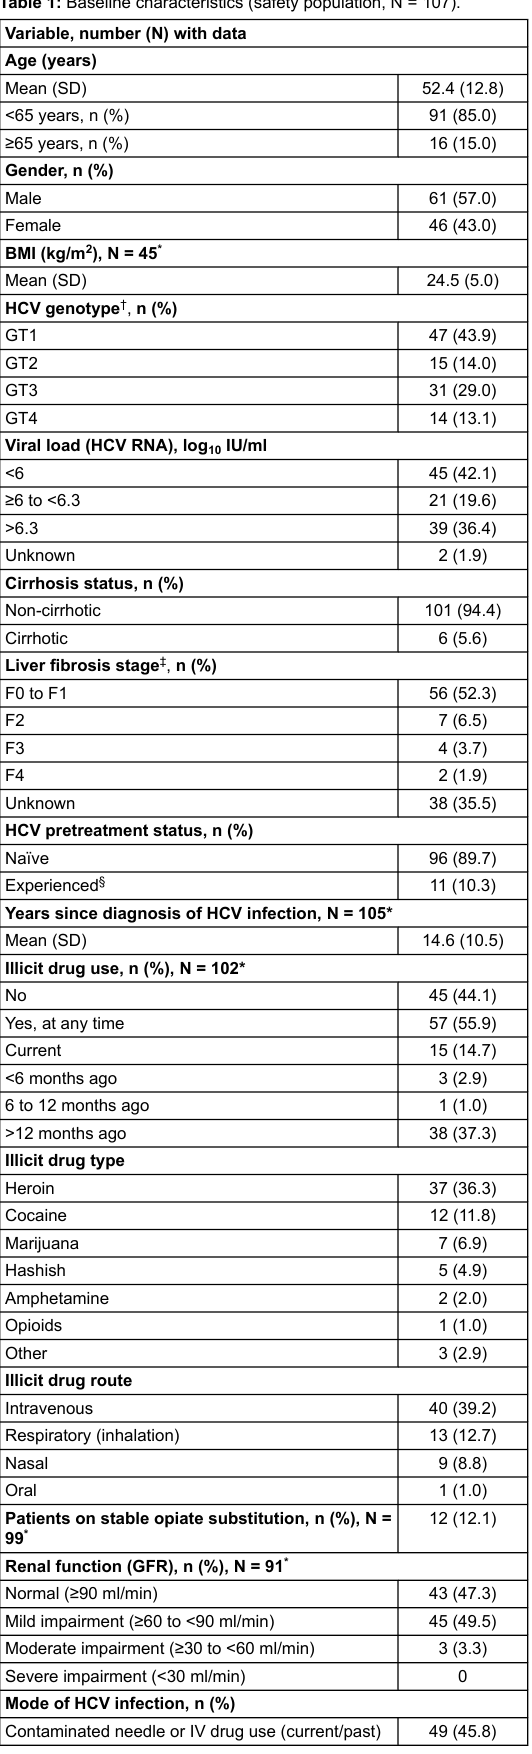
Table 1: Baseline characteristics (safety population, N =